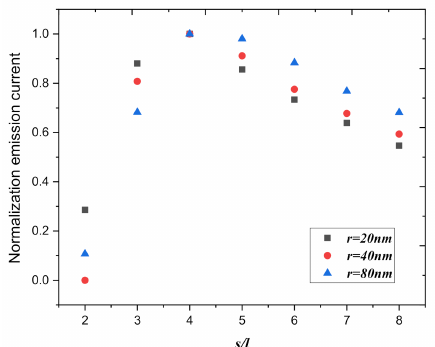
Figure 7. The normalization field emission current in 10 cm 2 as a function of the normalization spacing, for the aspect r (one-half thickness of graphite nanoplatelet), is chosen to be 20 nm, 40 nm, and 80 nm ( U = 200 V, d = 2.75 µ m).